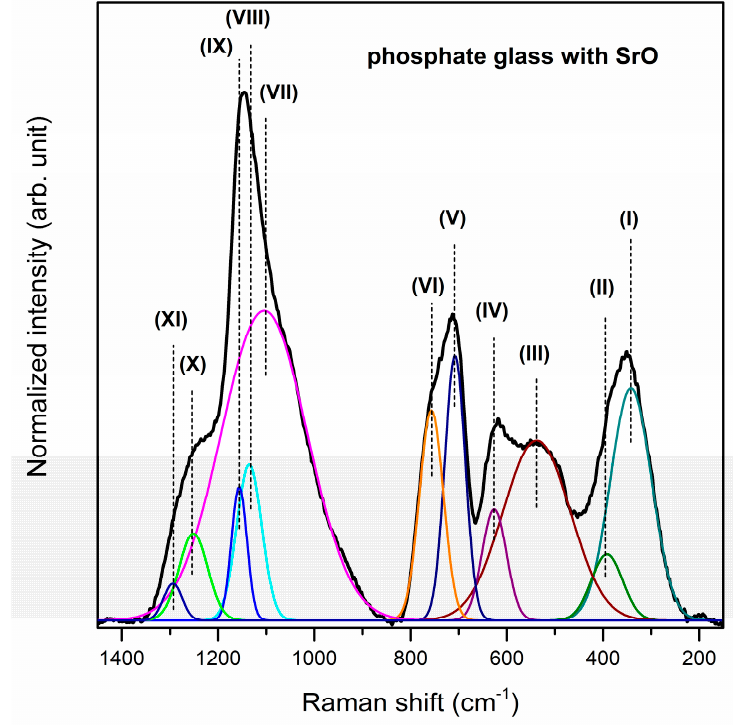
Figure 5. Deconvoluted Raman spectra of phosphate glass with SrO as oxide glass modifier.